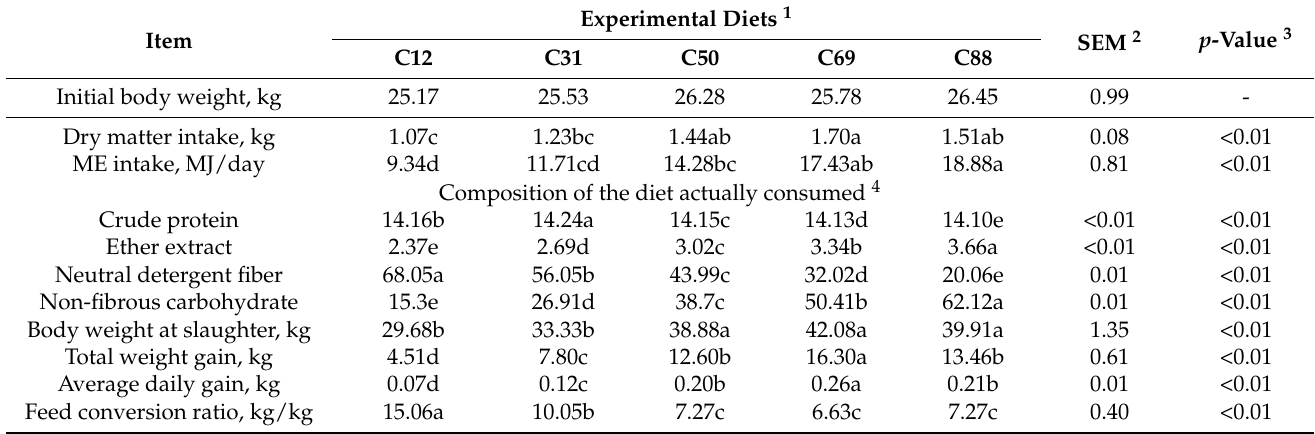
Table 3. Composition of the diet actually consumed by Santa Ines lambs who received different forage-to-concentrate